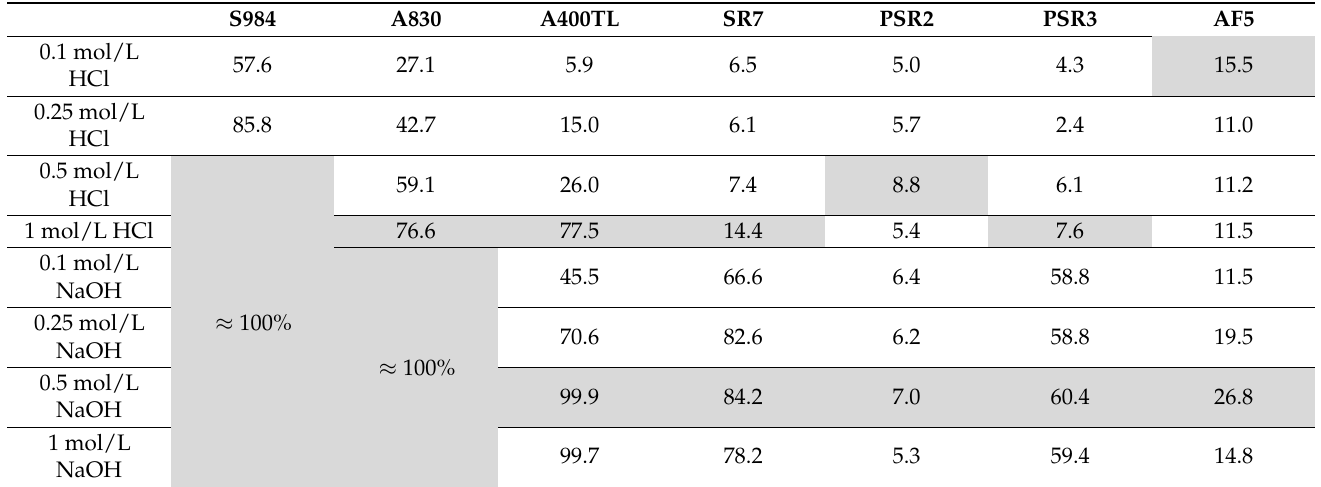
Table 6. Vanadium desorption yield from S984, A830, A400TL, SR7, PSR2, PSR3, AF5.